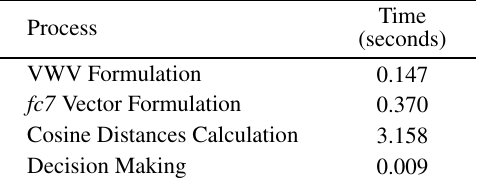
Table 2. Time results of Synergy and its sub-processes.